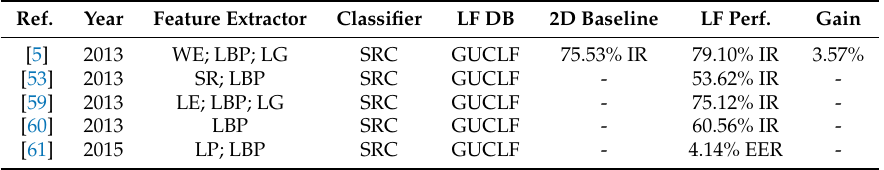
Table 5. Summary of multi-focus-based face recognition methods. Performance is assessed in terms of identification rate (IR) for all methods except for [61], where the equal error rate (EER) is reported. The abbreviations used in this table: WE–wavelet energy image selection; LBP–local binary pattern; LG–log-Gabor filter; LE–log-entropy image selection; SP–super-resolution; LE–log-entropy; LP–Laplacian pyramid image fusion; SRC–sparse reconstruction classifier; SRC–sparse reconstruction classifier; GUCLF–GUC light-field